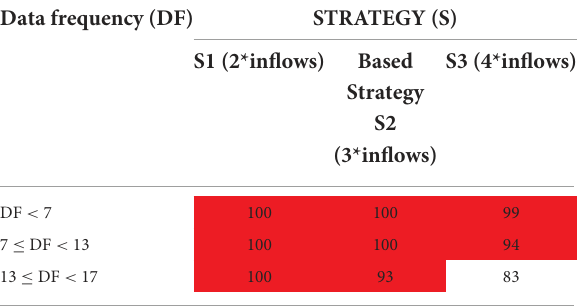
TABLE 10A Probabilities of the OPREM meeting the lower band width value given the data frequency (ratio analysis). Data frequency (DF)